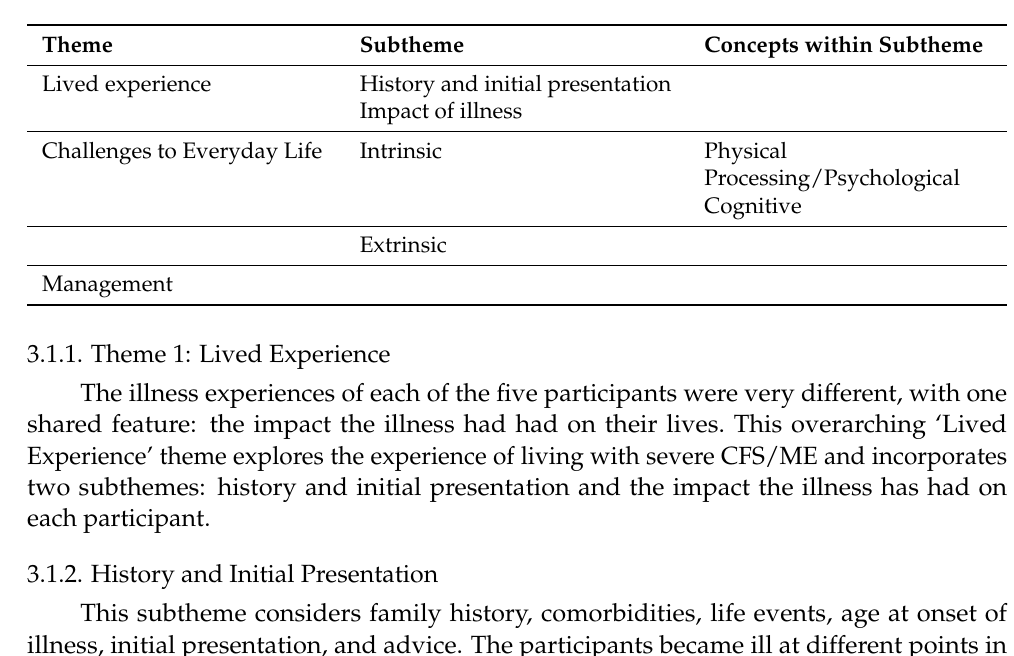
Table 2. Themes and